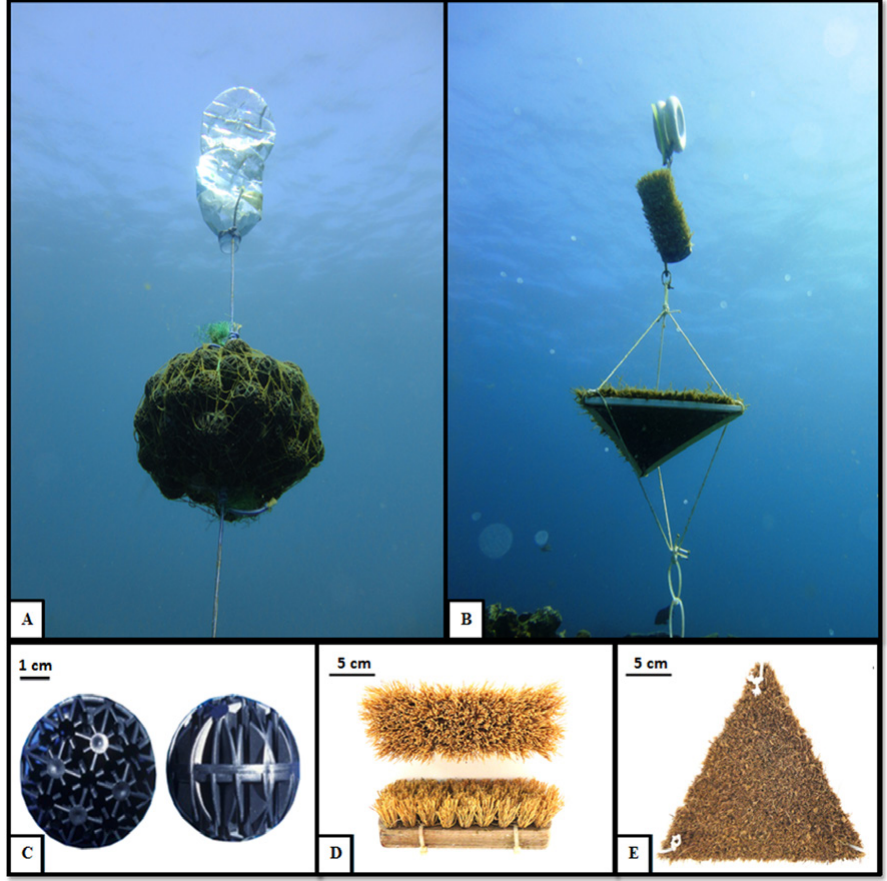
Fig. 2. – The three types of collector tested in this work. General image of (A) the plastic biofilter ball collector and (B) the vertical brush and triangular mat collectors deployed underwater. Detailed image of (C) a single biofilter ball, (D) vertical brush of vegetal bristles and (E) horizontal triangular mat of coconut